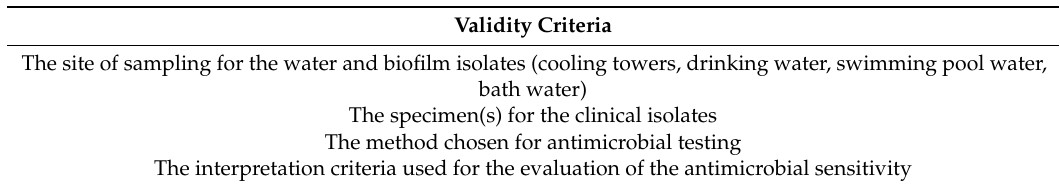
Table 2. The validity criteria developed a